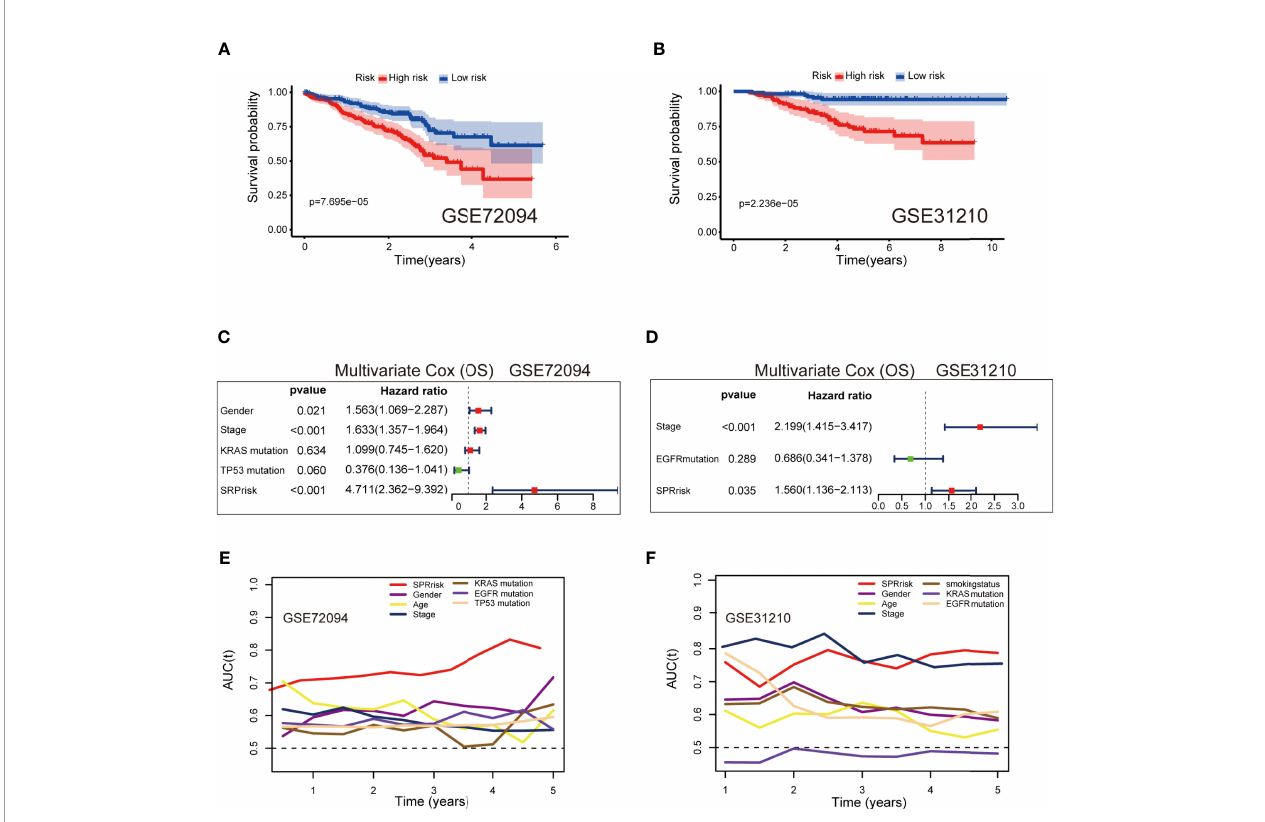
FIGURE 6 | Validation of the 9-gene signature in the independent validation sets. (A, B) Kaplan – Meier curves of overall survival time between the high- and low-risk groups using the log-rank test in the GSE72094 and GSE31210 datasets. (C, D) Forest plot with hazard ratios from the multivariable Cox proportional hazards regression analysis in the GSE72094 and GSE31210 datasets. (E, F) Areas under the curve of time-dependent receiver operating characteristic curves of risk factors in the GSE72094 and GSE31210